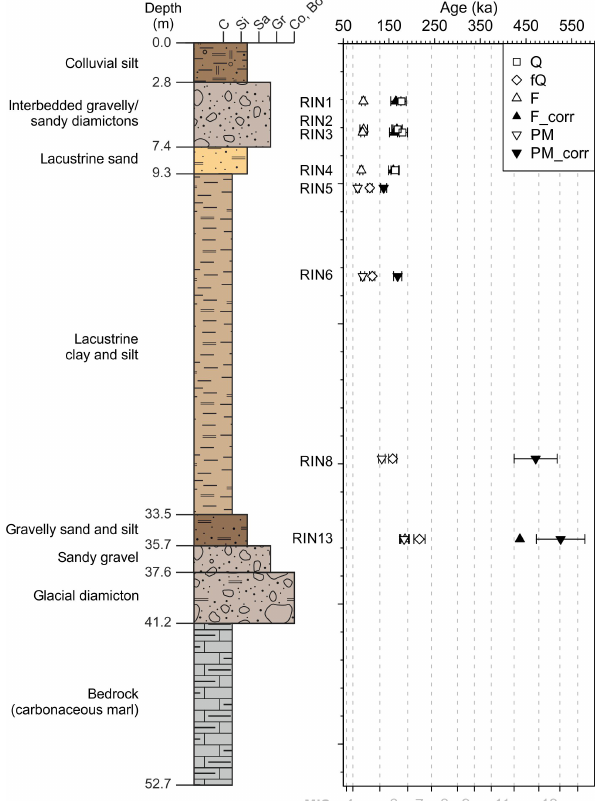
Figure 2. Core log and age–depth model of the investigated site. Ages for all minerals and fractions are presented with 1 σ un- certainty. Fading corrected ages are calculated following Kars et al. (2008). Grain size fractions are subdivided into clay (C), silt (Si), sand (Sa), gravel (Gr), and a combined fraction of cobbles and boul- ders (Co,